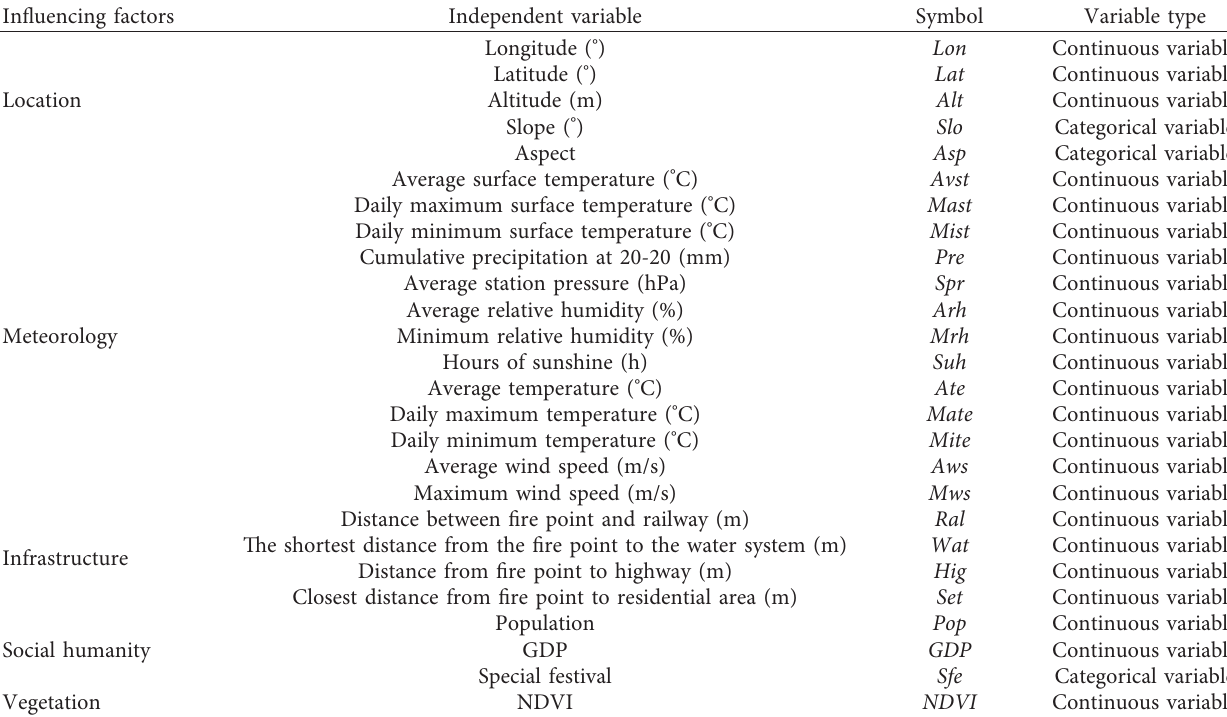
Table 3: Overview of independent